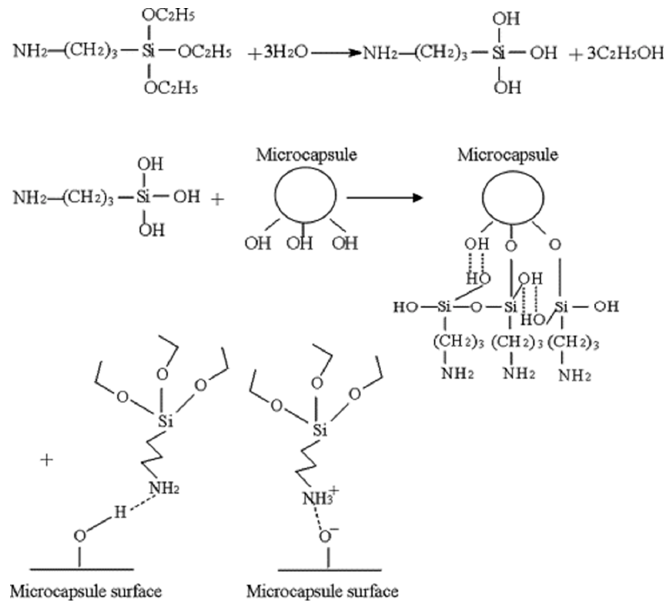
Figure 3. Theoretical model of chemical bonding of silane coupling agent